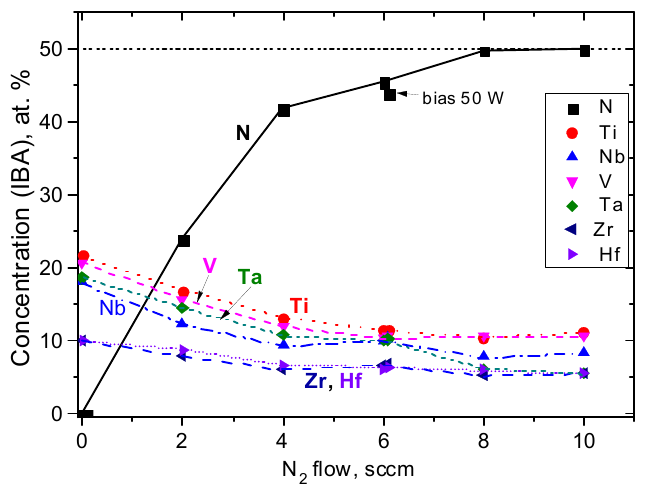
Figure 10. The concentrations of TM and nitrogen determined by IBA methods in the studied reactive HiTUS TiNbVTaZrHf-xN coatings in dependence on the additions of nitrogen.